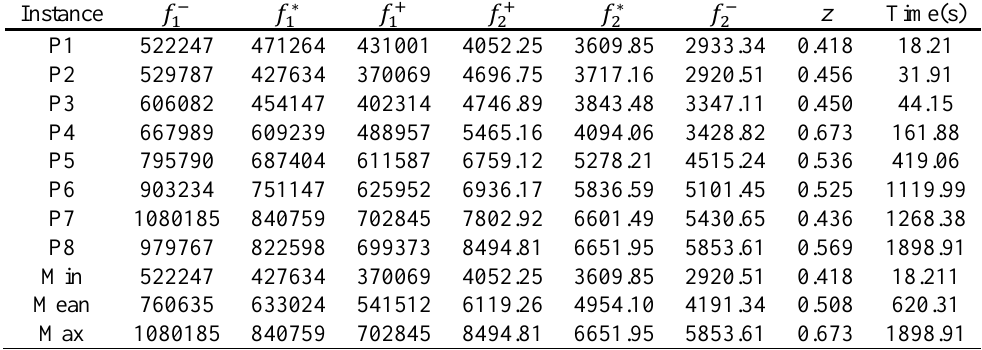
Table 9. Computational results of solving the eight random instances by utilizing the weighting method, and solving by the standard solve